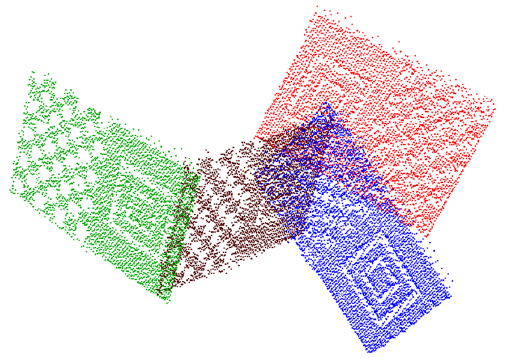
Figure 6. Calibration plate point clouds captured by different cameras.